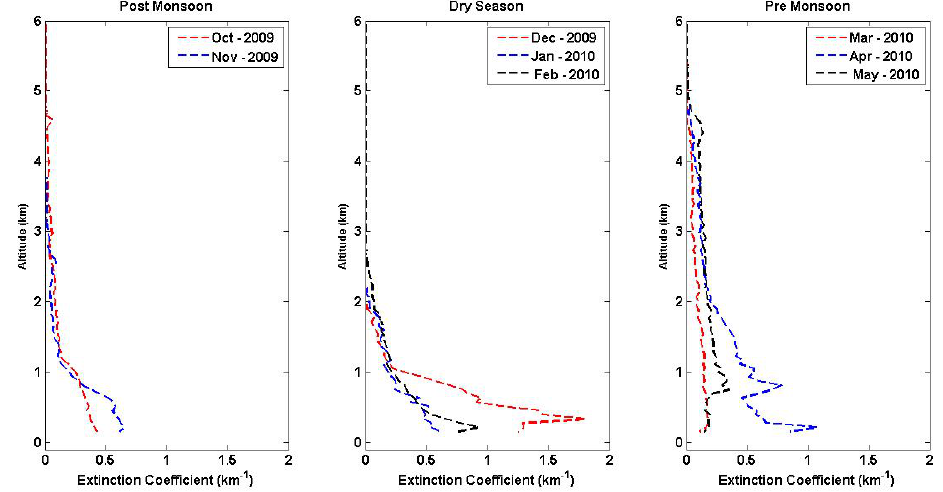
Fig. 11. Monthly mean LIDAR extinction profiles (532nm) from CALIPSO for the grid (26–27 ◦ N and 80–82 ◦ E) for post-monsoon, dry and pre-monsoon seasons, respectively. SVI 1 is located within this